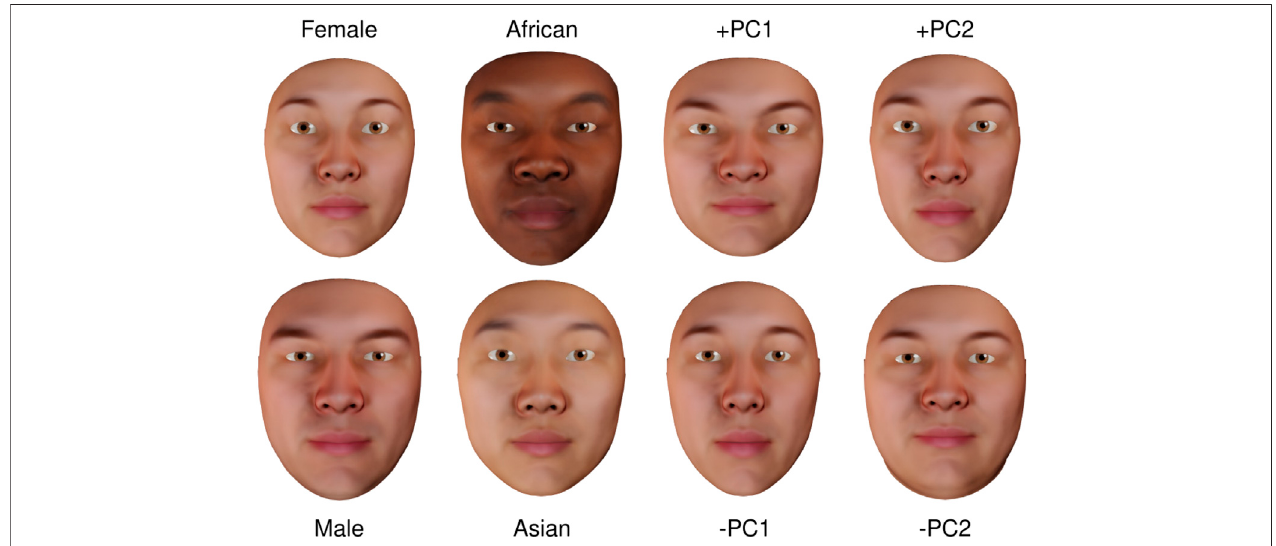
FIGURE 3 | Identity components of the FexMM rendered with an average texture. The fi rst two components are obtained via regression analysis, the latter two via PCA. Please note that texture related facial details are missing due to averaging.